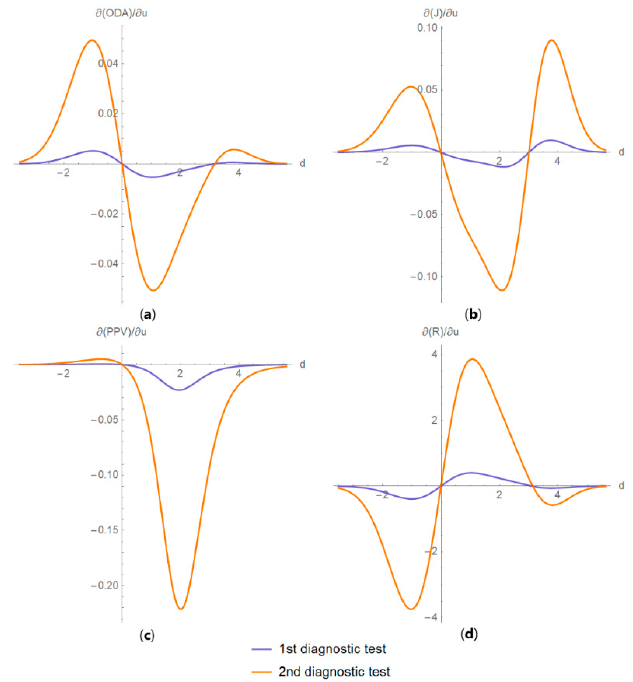
Figure 15. DAM relative differences against diagnostic threshold plots. Plots of the relative difference of the ( a ) likelihood ratio for a positive result ( LR +), ( b ) likelihood ratio for a negative result ( LR − ), ( c ) diagnostic odds ratio (DOR) and ( d ) Youden’s index ( J ) of two screening or diagnostic tests measuring the same measurand with different uncertainties, against diagnostic threshold ( d ) curves, with the respective parameters in Table 4.